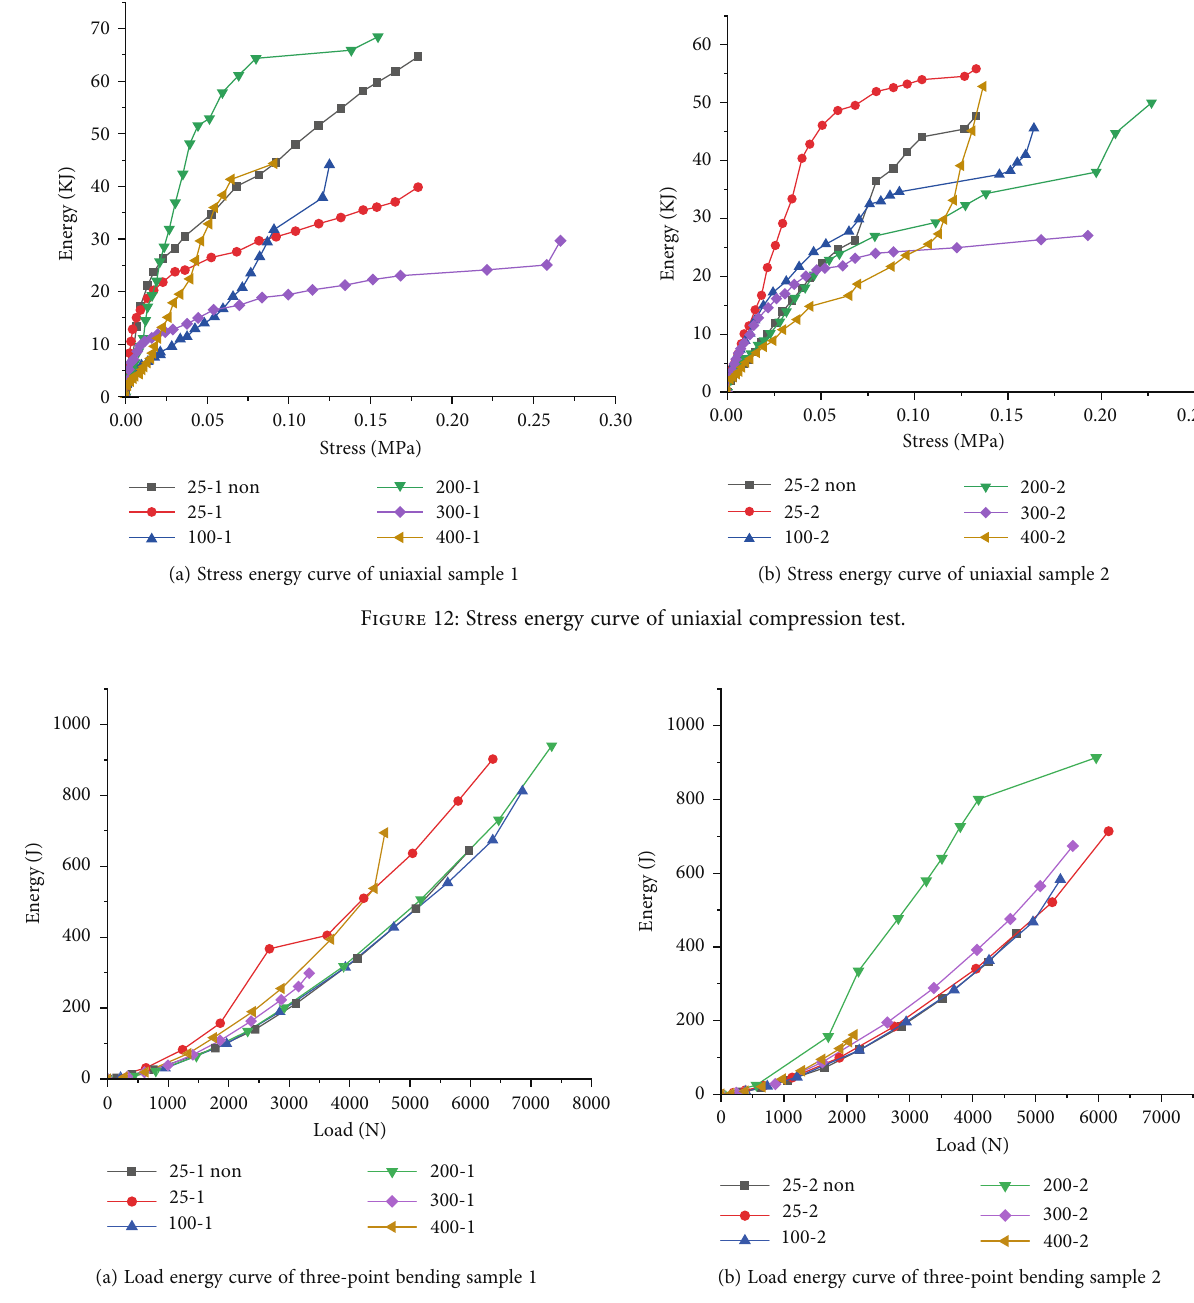
Figure 13: Load energy curve of three-point bending